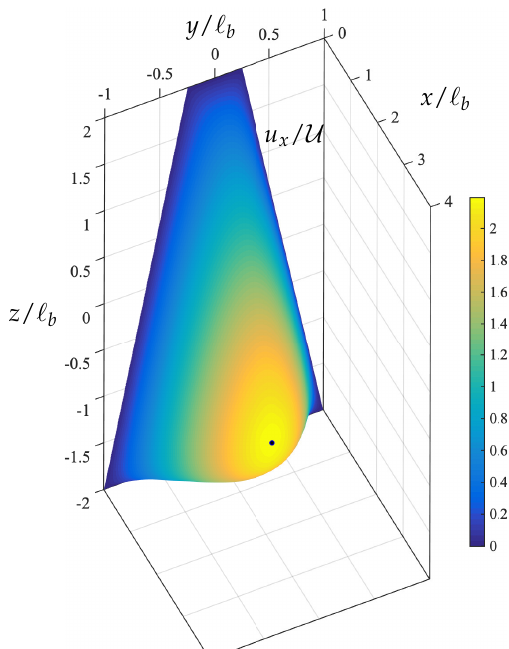
Figure 4. The velocity profile u x / ratio (cid:96) a / (cid:96) b = 0.25. The maximum velocity is located at z / (cid:96) b